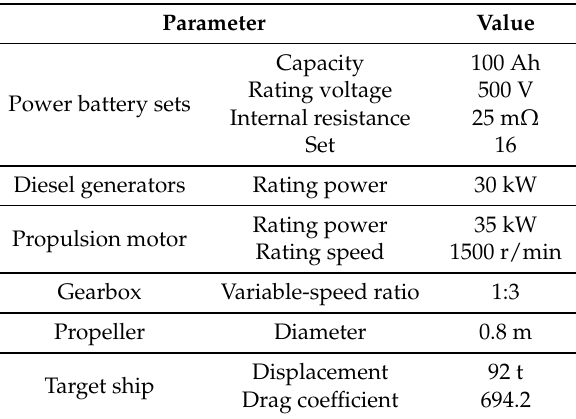
Table 1. Main parameters of the experimental